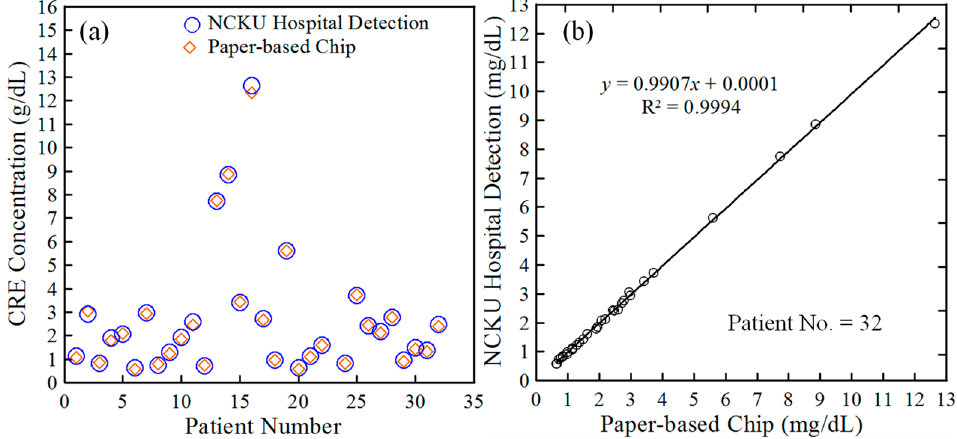
Figure 5. Comparison of human serum creatinine detection results obtained using proposed paper-based system and traditional macroscale system ( a ) a scatter-plot and ( b ) a related-plot by the two methods.